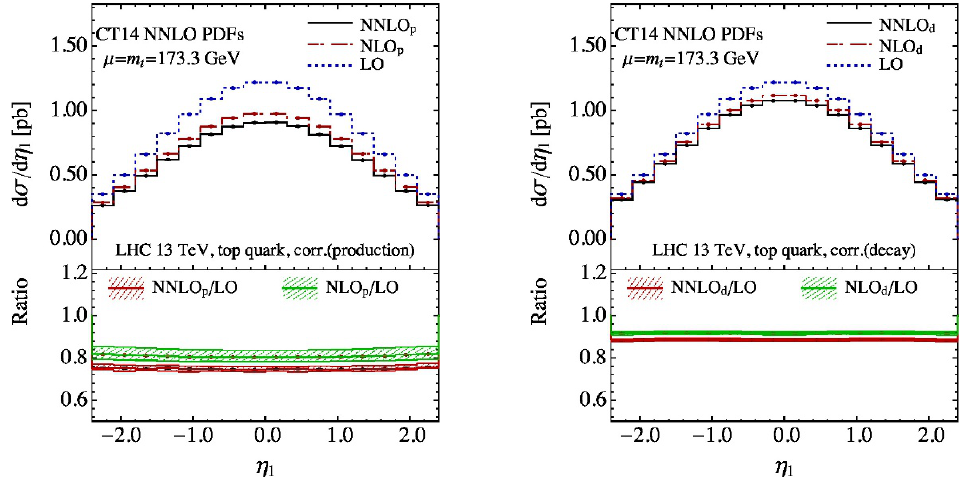
Figure 26 . Predicted pseudo-rapidity distribution of the charged lepton from t -channel single top- quark production and decay at 13 TeV after (cid:12)ducial cuts, including corrections from production and decay,